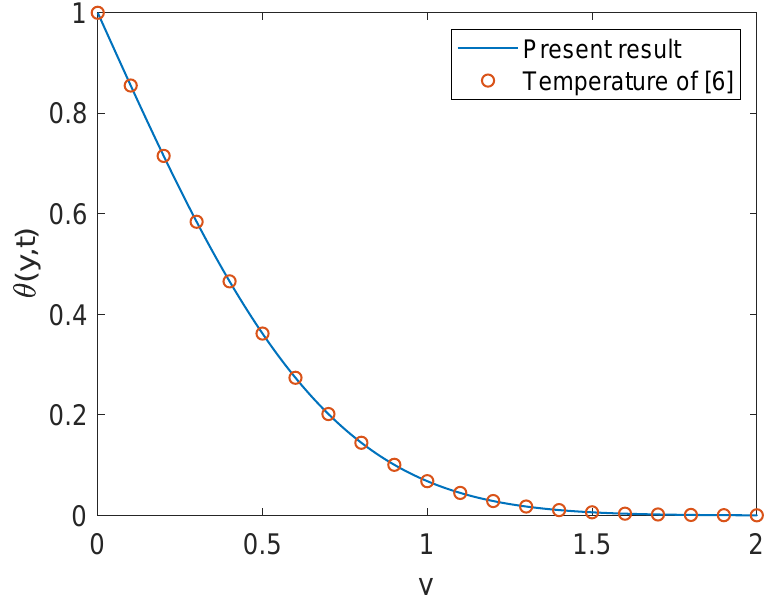
Figure 16. Temperature comparison between present work and Das [6] when Pr = 6.2, Nr = 0.5, Q = 0, φ = 0.1 and t = 0.5.